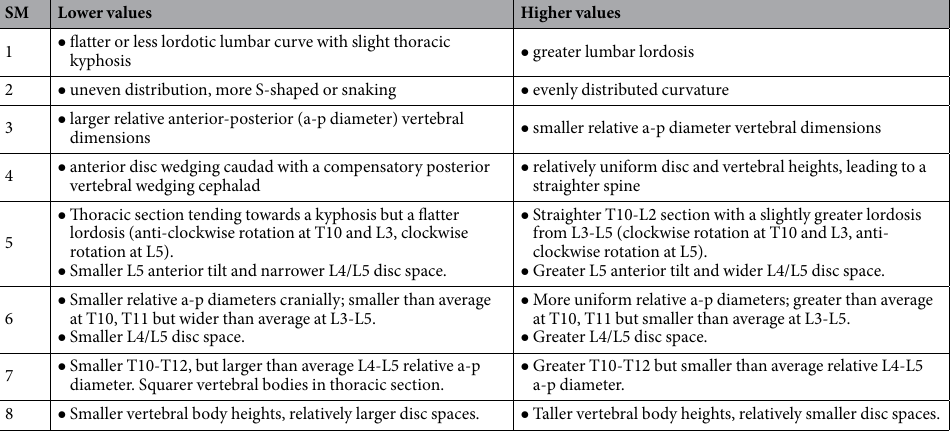
Table 1. Characteristics of spine modes (SM) 1 to 8 in the MRC National Survey of Health and Development. SM: spine